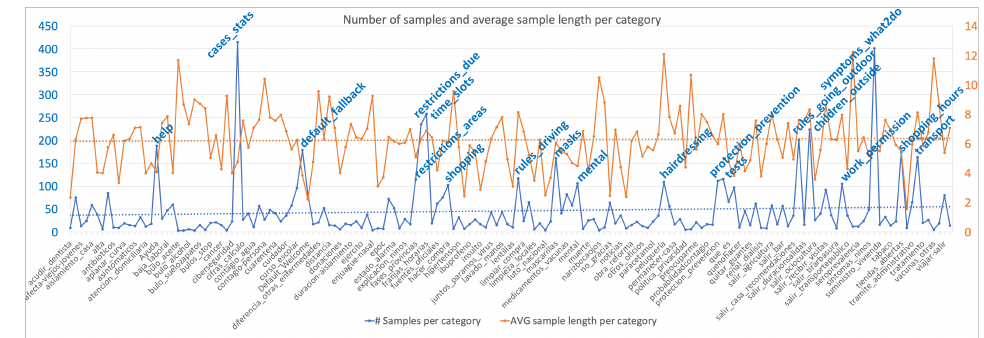
Figure 1. Histogram of amount of samples per class and average sample length per